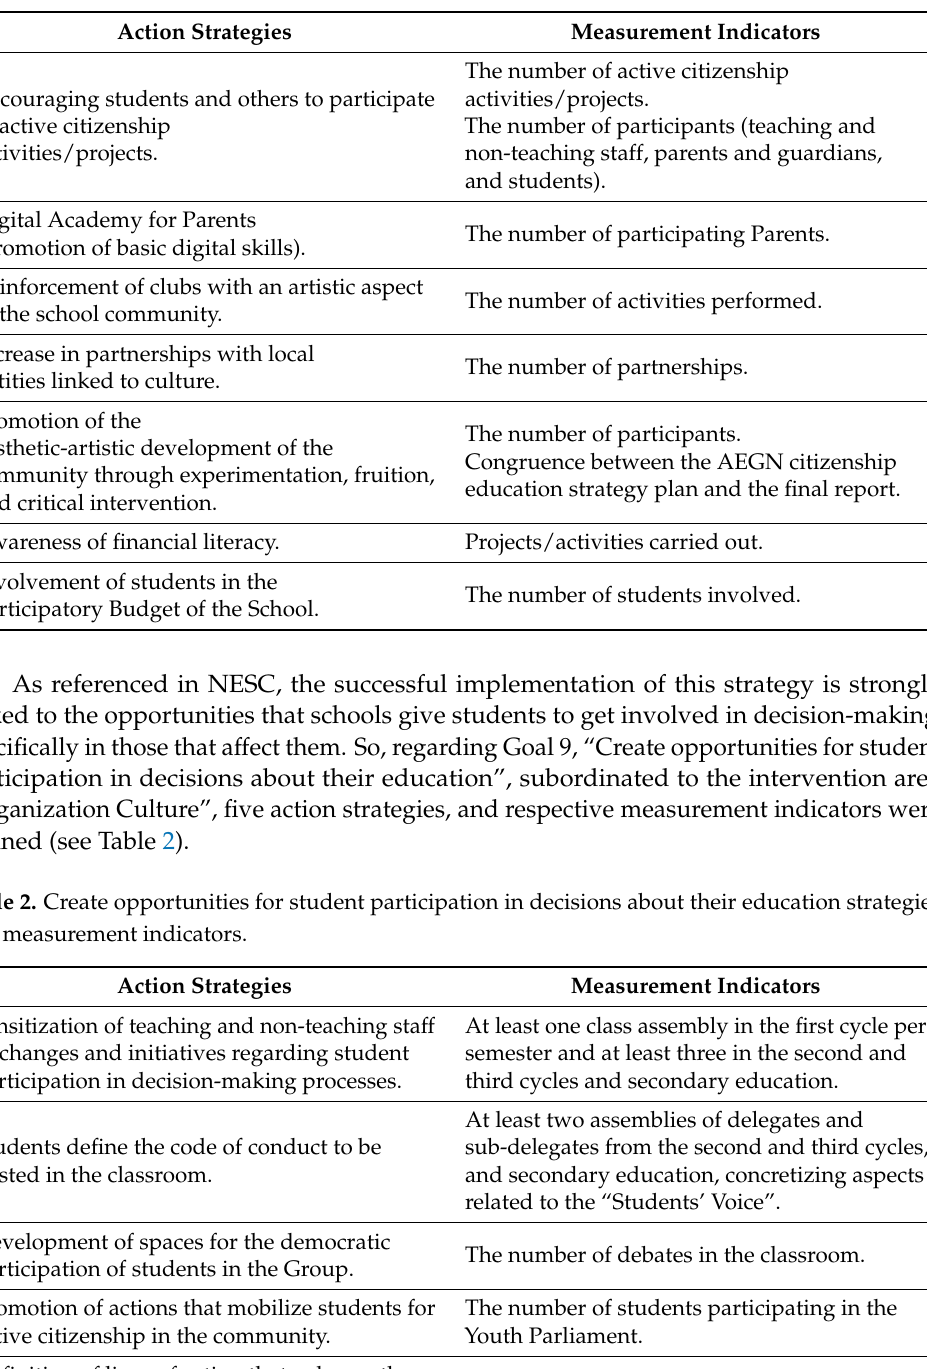
Table 1. Assessment, teaching, and learning strategies and measurement indicators.